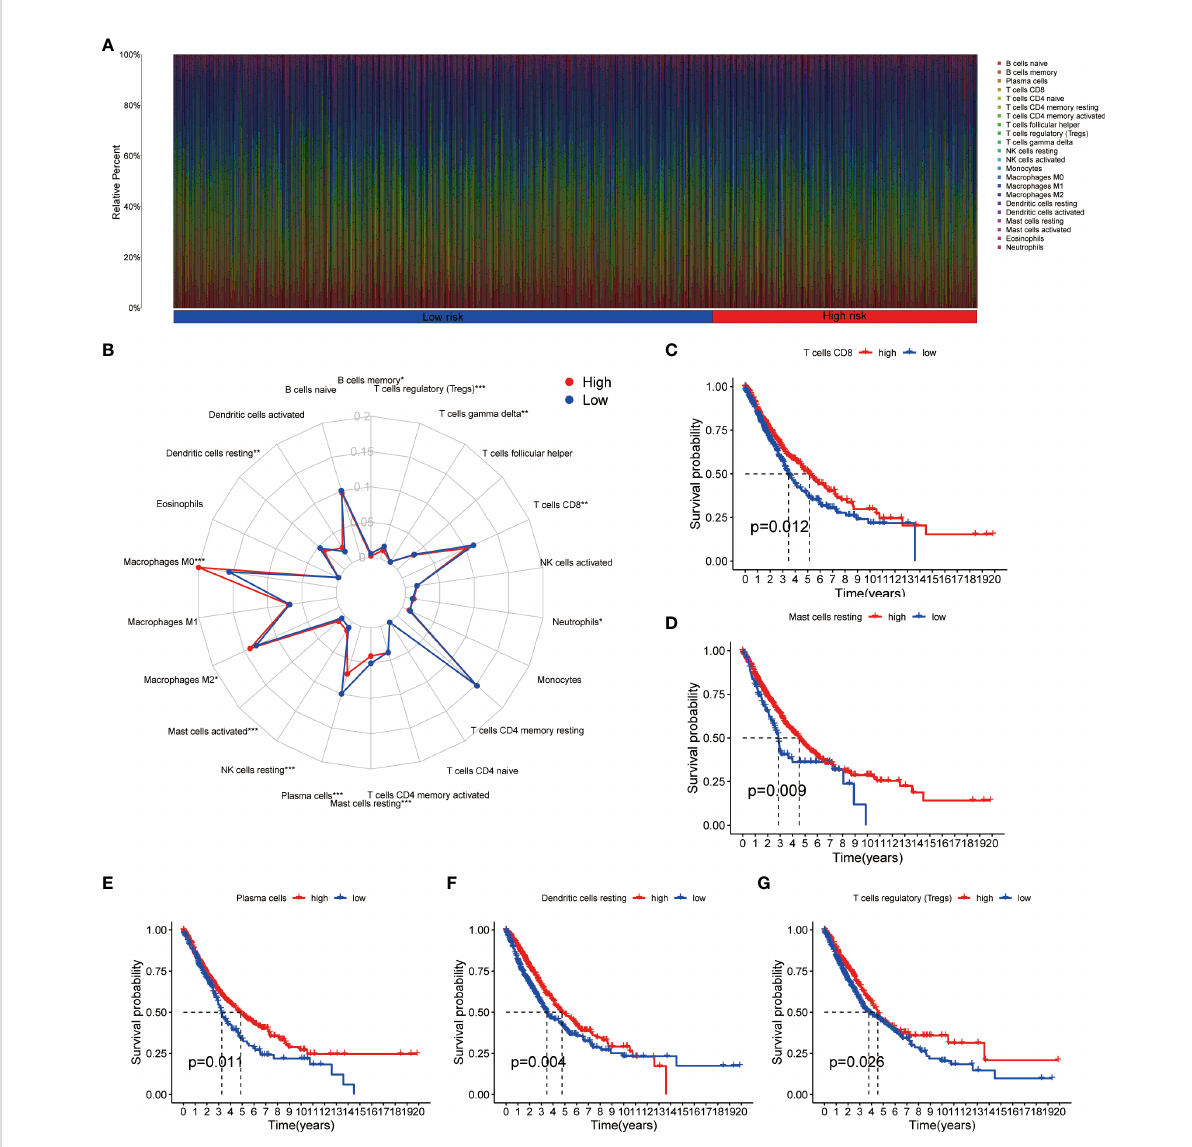
FIGURE 6 Immune cell in fi ltration analysis in NSCLC. (A) Relative in fi ltration proportions of 22 immune cells in each NSCLC sample based on CIBERSORT method. (B) The radar map reveals the distribution of 22 immune cells between high- and low-risk groups. (C – G) Comparison of overall survival for NSCLC patients with different in fi ltration levels of CD8+ T cells (C) , resting mast cells (D) , plasma cells (E) , resting dendritic cells (F) and regulatory T cells (G) in the training cohort, respectively. NSCLC, non-small cell lung